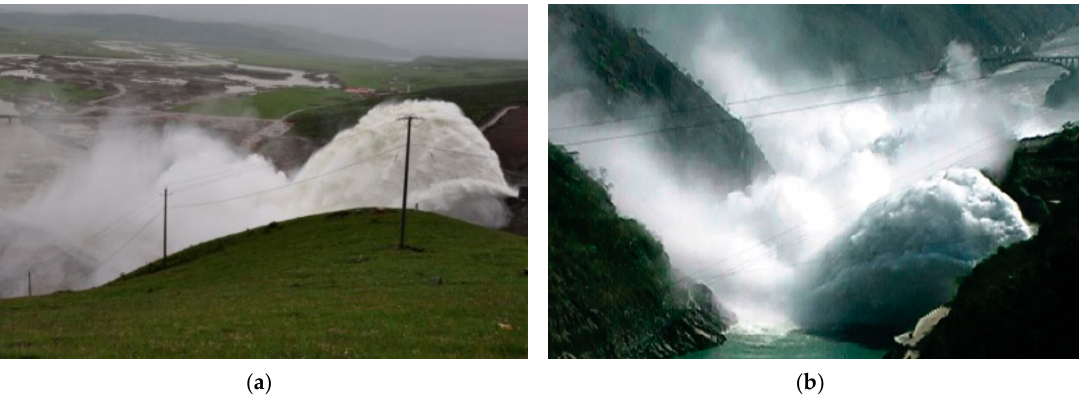
Figure 1. Flood discharge atomization caused by trajectory energy dissipation. (a) Nazixia Hydropower Station and (b) Dongjiang Hydropower Station.